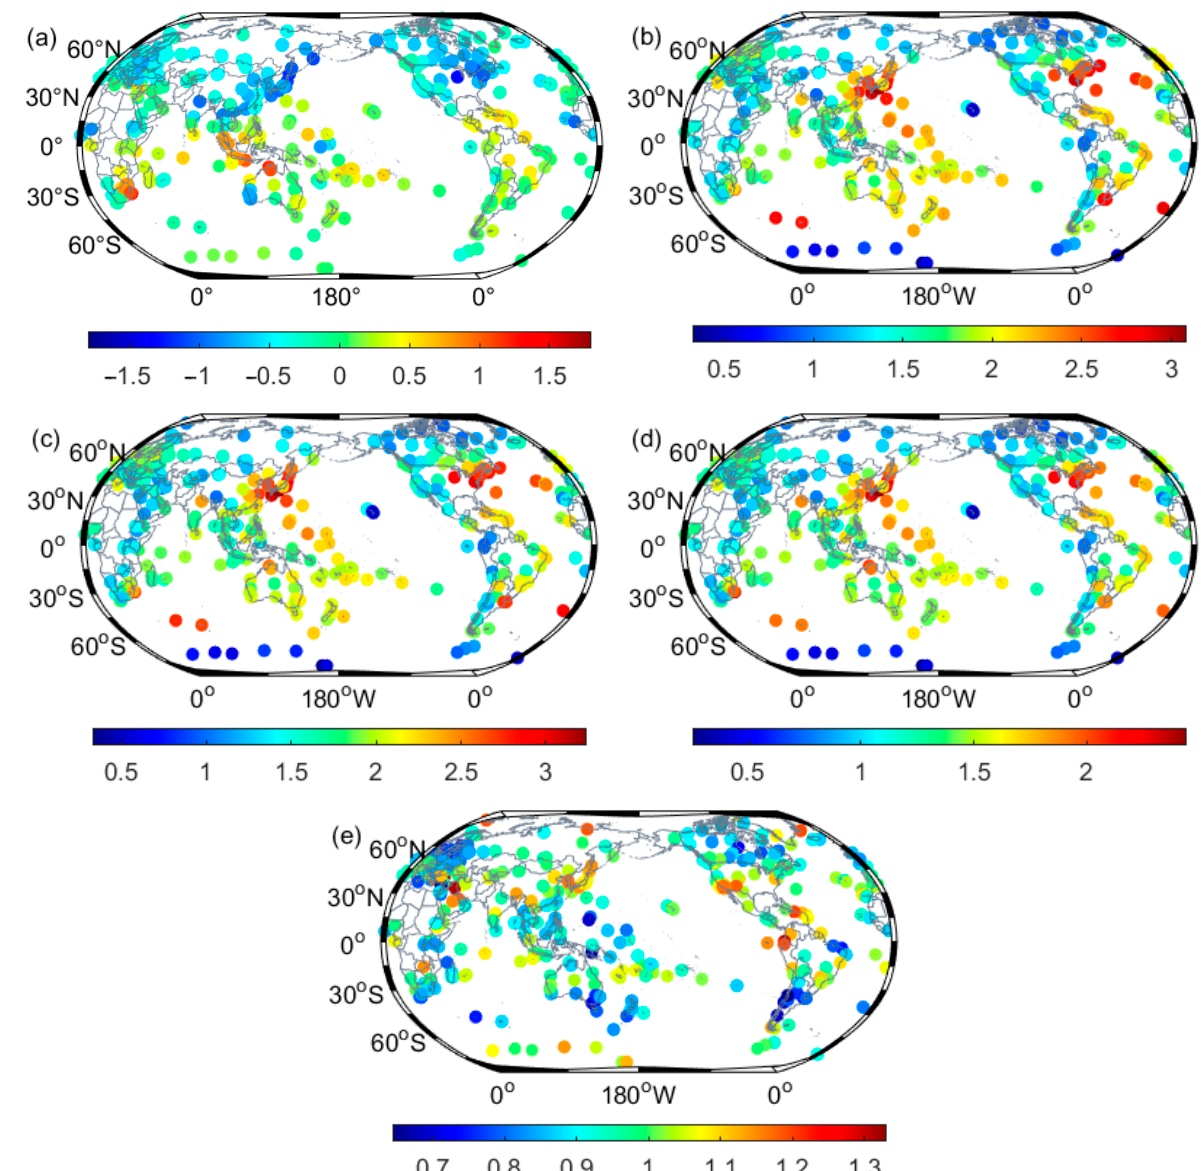
Figure 12. Global distribution of bias: ( a ), STD ( b ), RMSE ( c ), MAE ( d ), R ( e ) transformer ZTD.